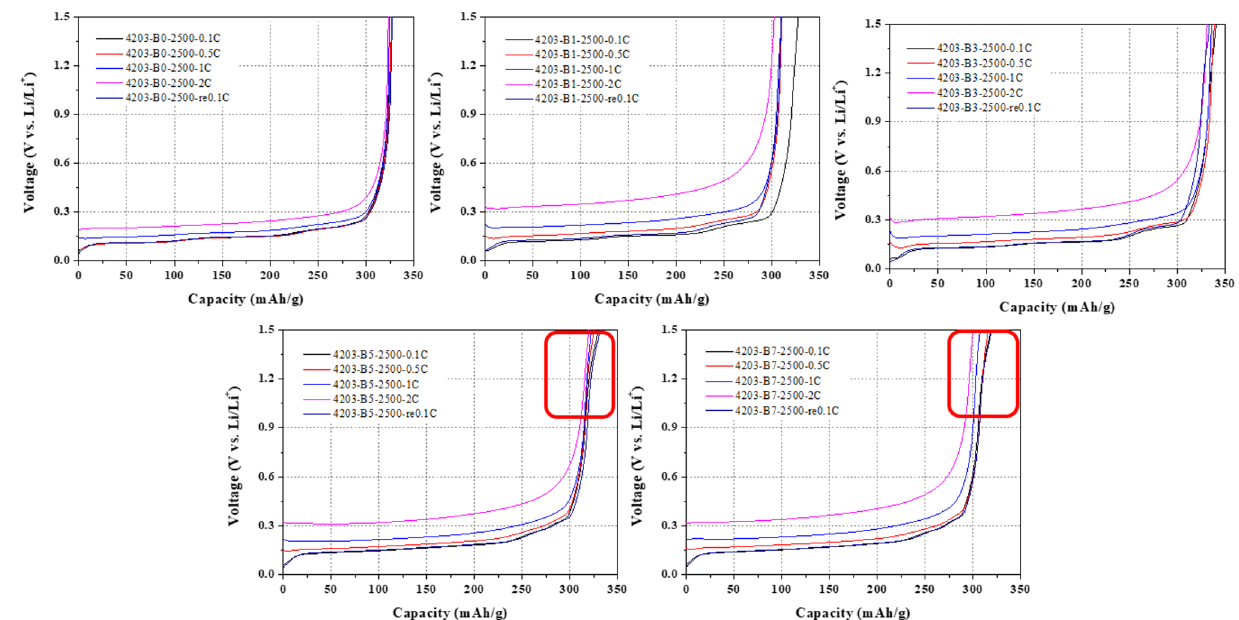
Fig. 9 Discharge profile of C-rate performance of